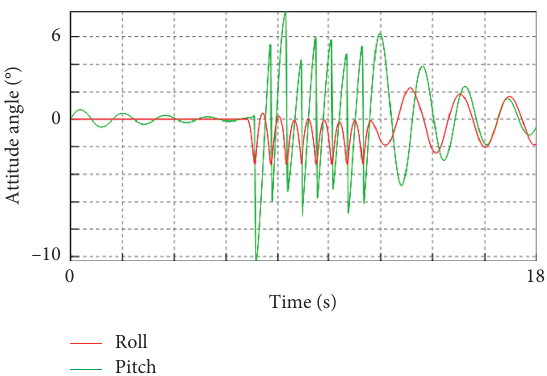
Figure 4: Change of the attitude angle of the vehicle using a single- bogie structure on straight driving.